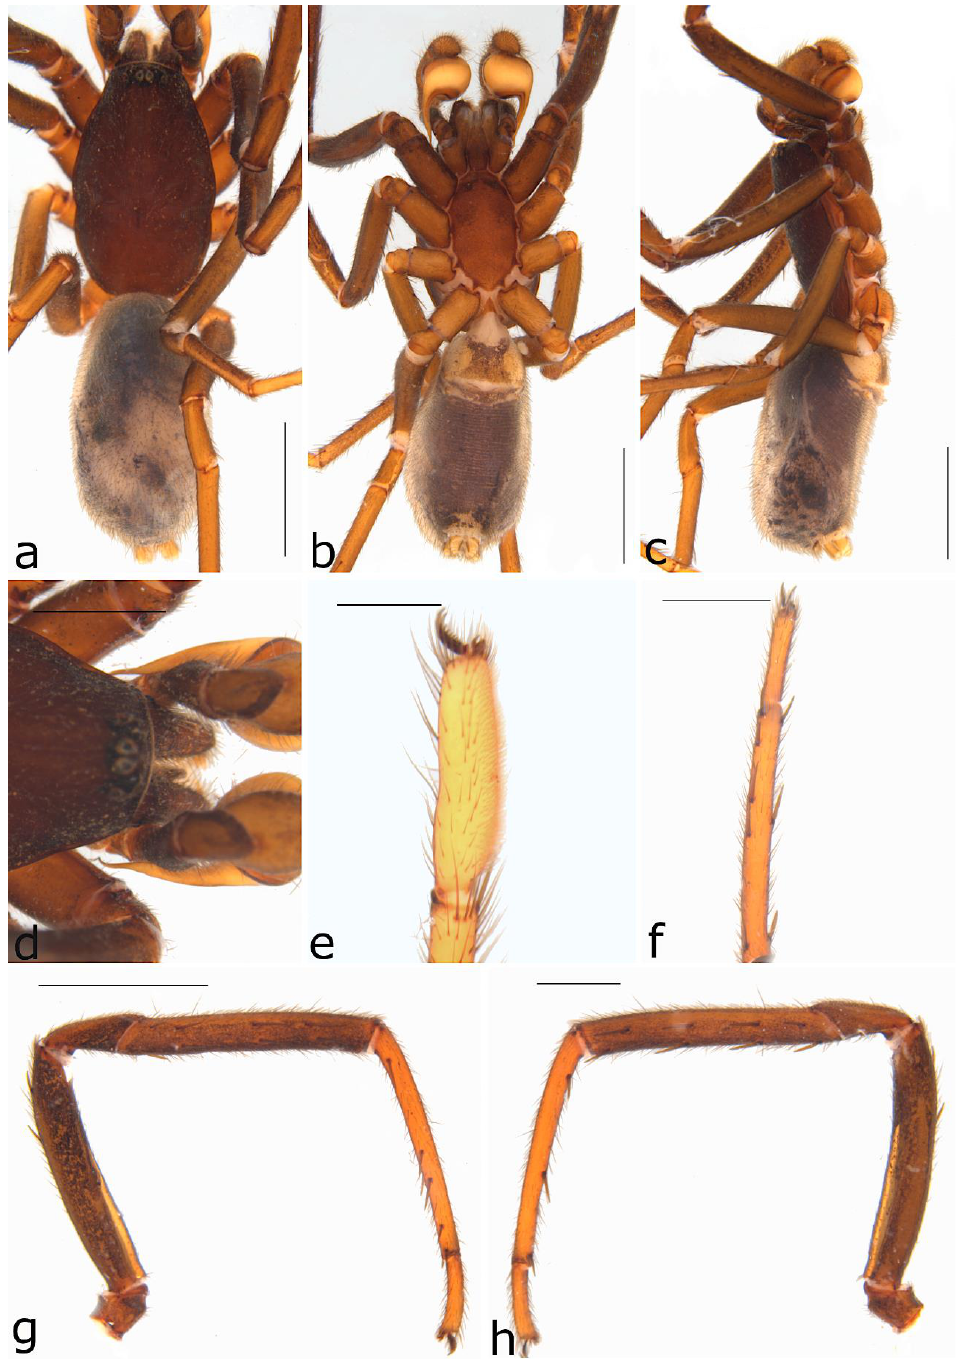
Figure 17. Ariadna formosa sp. nov. ♂ holotype (SAMA NN10565) from Indulkana (SA): ( a ) habitus, dorsal view; ( b ) same, ventral view; ( c ) same, lateral view; ( d ) eyes, dorsal view; ( e ) left metatarsus IV, preening comb, retrolateral view; ( f ) left leg I, ventral view; ( g ) same, prolateral view; ( h ) same, retrolateral view. Scale bars ( a – c ) = 2 mm, ( d ) = 1 mm, ( e ) = 0.5 mm, ( f ) = 1 mm and ( g , h ) = 2 mm.